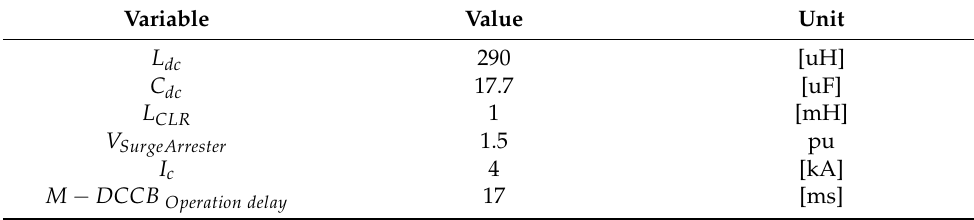
Figure 6. Implemented Active Injection M-DCCB. Table 2. Implemented M-DCCB parameters.